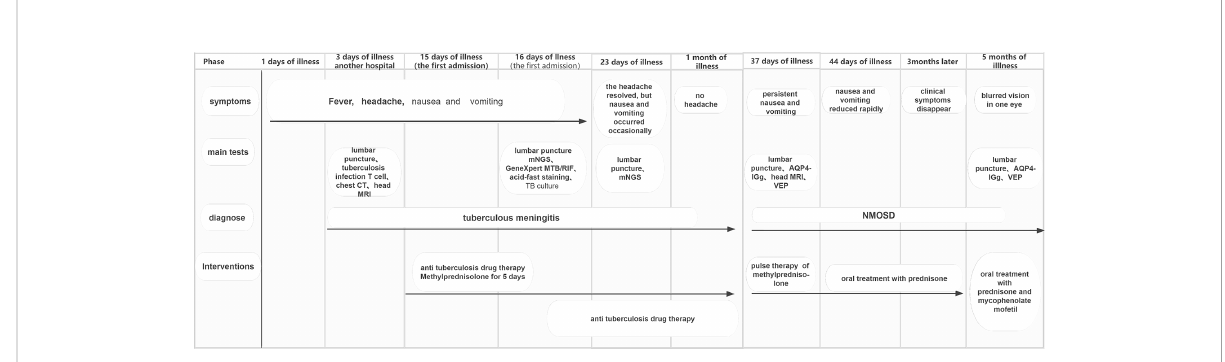
FIGURE 2 Symptoms and interventions of patients before and after treatment.